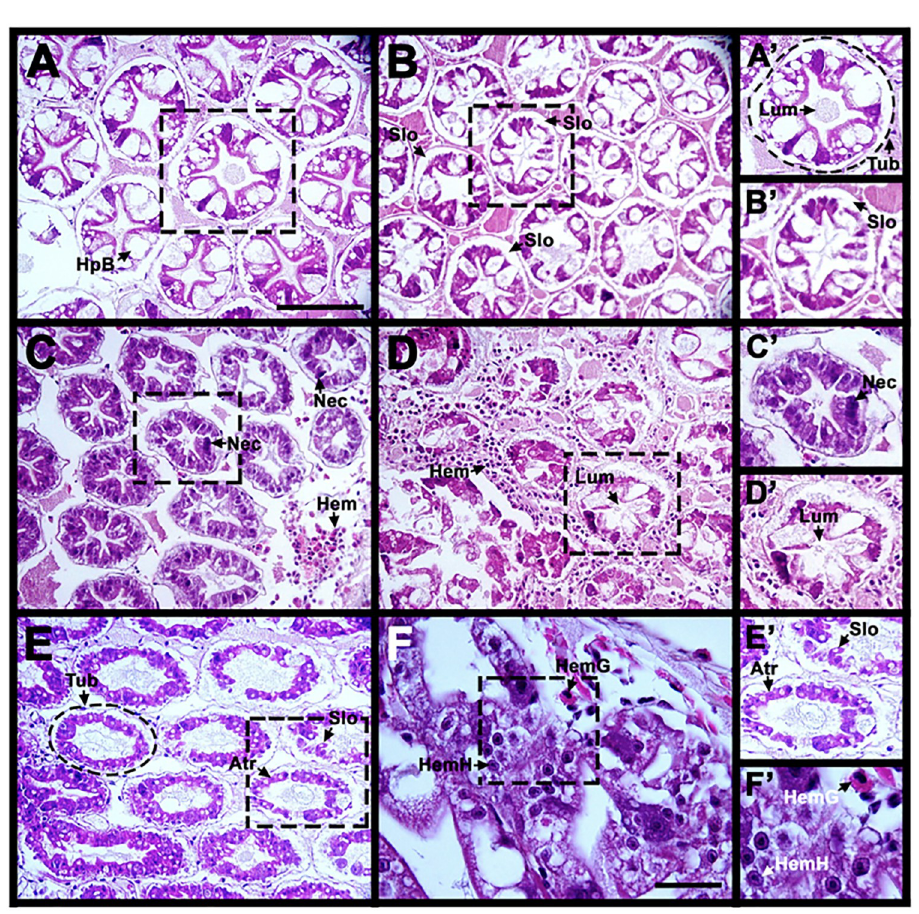
Fig 2. Light micrographs of longitudinal sections of hepatopancreas (Hp) from Litopenaeus vannamei infected with Vibrio parahaemolyticus IPNGS16. Sections were stained with Hematoxylin-eosin, five samples were analyzed for each different time point. Untreated sample at 0 h. Normal Hp has clear tubules (Tub,) (A’), a star-shaped lumen (Lum) (A’), and B-cells (HpB). B- F). Infected samples at different time point post-infection. B,-B’). Small spaces can be seen between epithelial cells indicating sloughing cells (Slo) at 12 hpi. C- C’) Necrosis (Nec), and hemocyte infiltration (Hem) is present in the tubular epithelium, at 24 hpi. D) Presence of hemocyte infiltration is accompanied by lumen (D’) and epithelium reduction at 24 and 48 hpi. E- E’) Atrophy in epithelial cells (Atr) and sloughing cells in tubules is seen at 72 hpi. F) 100 × magnification to visualize granular (HemG) and hyaline (HemH) hemocyte infiltration. A’-F’) are magnified views of white dotted rectangle regions in panels (A- F) respectively. Scale bar: 100 μ m (A–E) and 30 μ m